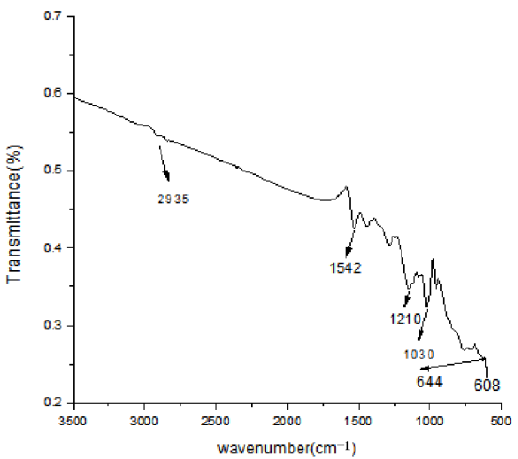
Figure 2. IR spectrum of the BaFe 12 O 19 -PPy